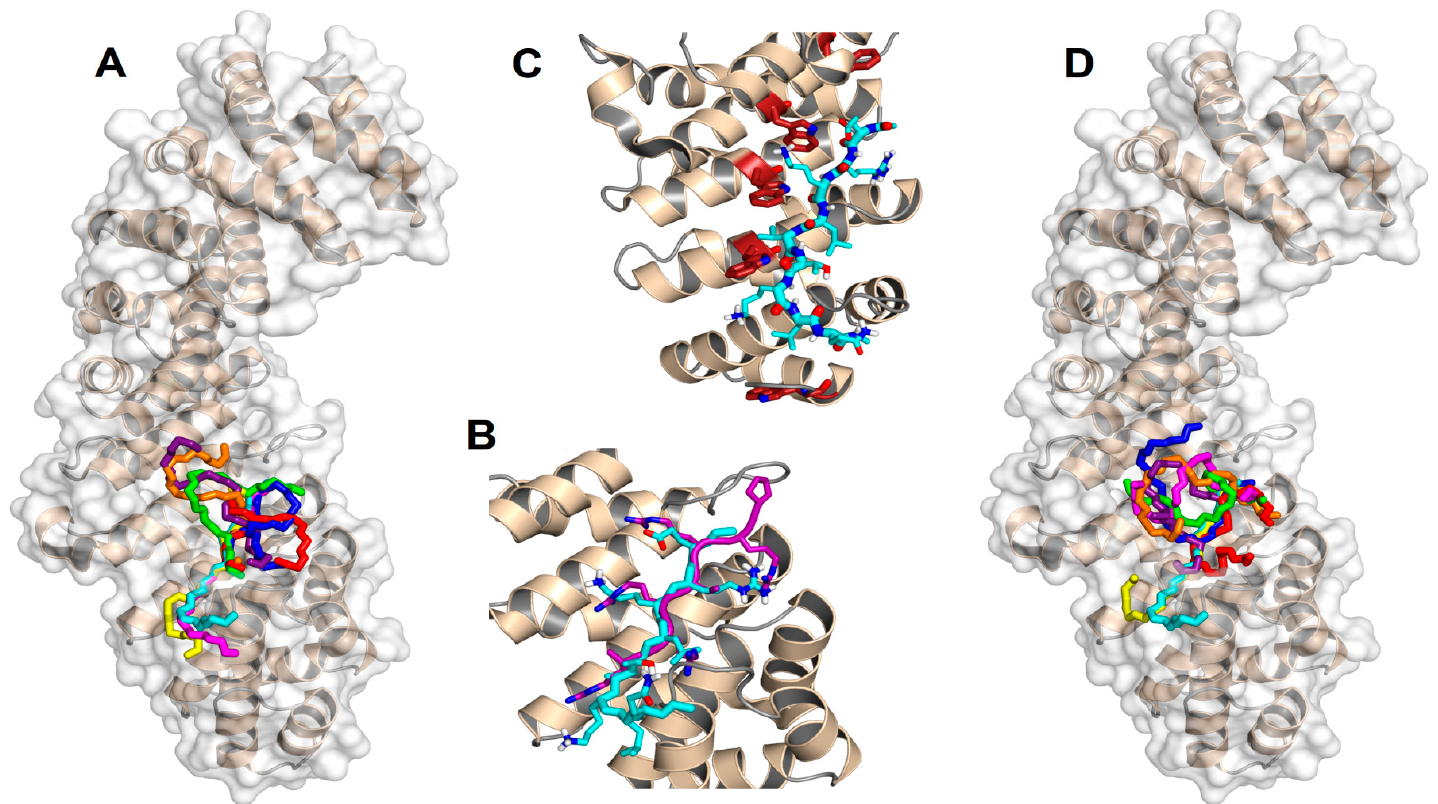
Figure 4. Predicted docking poses for the NLS of NUPR1 on importin. ( A ) Backbone (–N–C α –C– atoms) representation of the best eight docking poses on ∆ Importin for the wt sequence ERKLVTKLQ (the N terminus is on the top), which constitutes the core region for the NLS of NUPR1. ( B ) Most favorable binding pose for the same sequence (cyan), compared to the crystallographic conformation [46] of the NLS of the Epstein-Barr virus EBNA-LP protein (purple). For clarity, atoms are shown in standard colors only in the side chains of the two peptides, and the main-chain O and H atoms are omitted; apolar H atoms are not present. ( C ) Trp residues (brown) in the major NLS-binding site of importin play a key role in the binding of the most favorable conformation of the NLS of wild-type NUPR1. The view is slightly rotated with respect to previous representations to evidence the tryptophan side chains. ( D ) Most favorable docking poses for the eight peptide sequences: wild type (cyan), K65A (magenta), K69A (yellow), T68E (blue), K65AT68E (red), T68EK69A (green), K65AT68EK69A (orange), and pT68 (violet). PyMol was used for all displays.